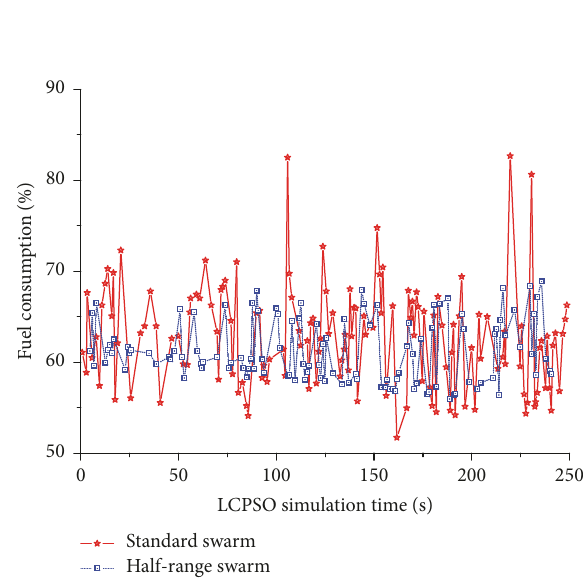
Figure 4: Result distribution with standard and half times range.